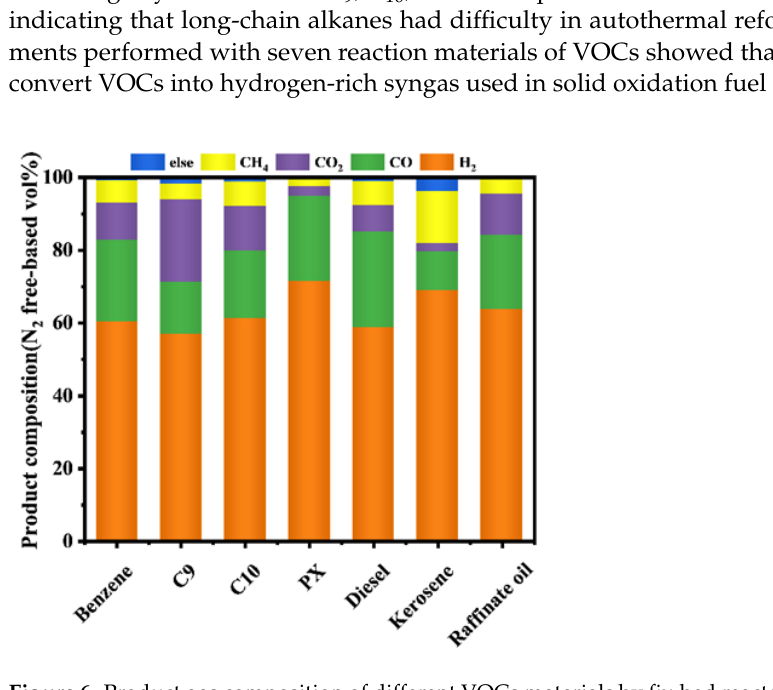
Figure 6. Product gas composition of different VOCs materials by fix-bed reactor. (Reaction condition: temperature = 700 °C, the flow rate of material = 0.2 mL/min, the flow rate of water = 0.31 mL/min, the flow rate of dry air = 317.4 mL/min). Table 2. Components of the mixture in elemental analysis.